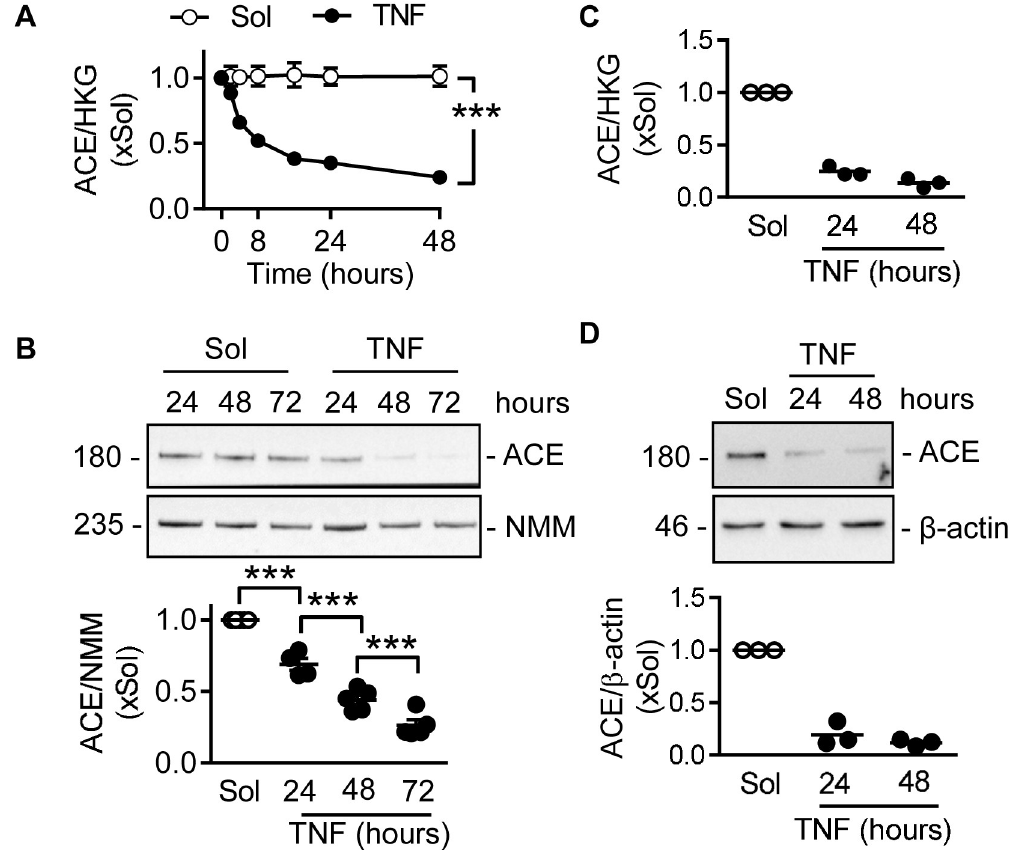
Fig 1. Effect of TNF α on ACE mRNA and protein expression in human endothelial cells. (A) Time course of the effects of TNF α (10 ng/mL) on ACE mRNA levels in human umbilical vein endothelial cells relative to a triplet of housekeeping genes (HKG); n = 6 independent cell batches (two-way ANOVA/Bonferroni). (B) Time course of the effects of TNF α on ACE protein expression in human umbilical vein endothelial cells relative to non-muscle myosin heavy chain (NMM); n = 4–5 independent cell batches (one-way ANOVA/Newman-Keuls). (C&D) Expression of ACE mRNA (C) and protein (D) in human umbilical artery endothelial cells; n = 3 independent cell batches. ��� P < 0.001.